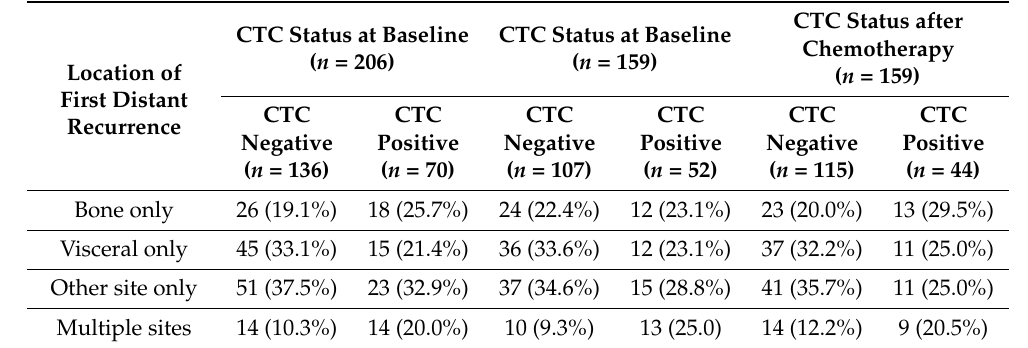
Table 2. Association between site of first metastatic disease recurrence and both CTC status at baseline (i.e. before chemotherapy) and CTC status after chemotherapy ( n = 206: all patients with CTC assessment at baseline, i.e., before chemotherapy; n = 159: only patients with CTC assessment both before and after chemotherapy).